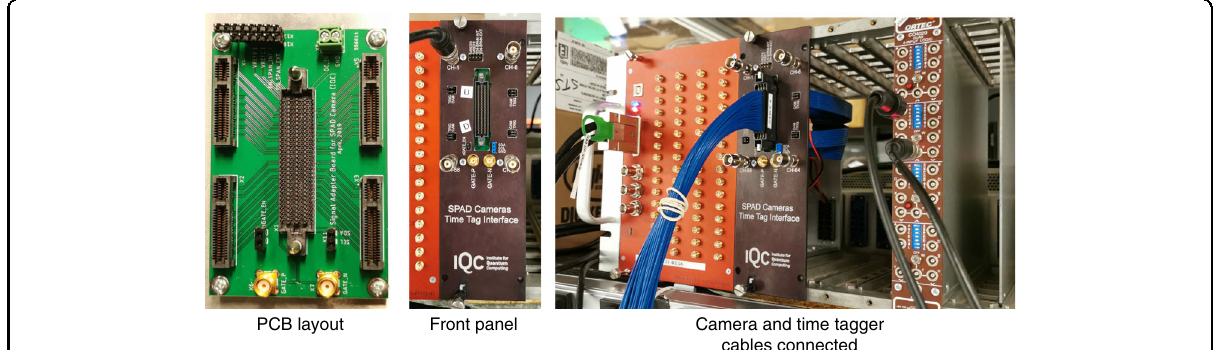
Fig. 8 Interface board. The camera output (64 LVDS pairs) are linked to an interface board, and divides the signals to 4 blocks of 16 LVDS pairs, as well as provides control signal inputs. The 4 signal blocks are directly interfaced with a high-speed time-tagger that can handle 64 input channels, up to 1